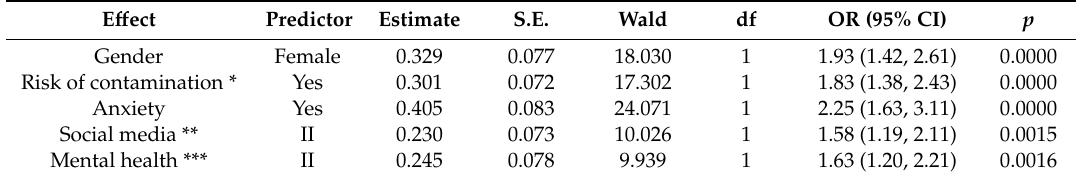
Table 14. Prediction of sleep bruxism (SB) aggravation in